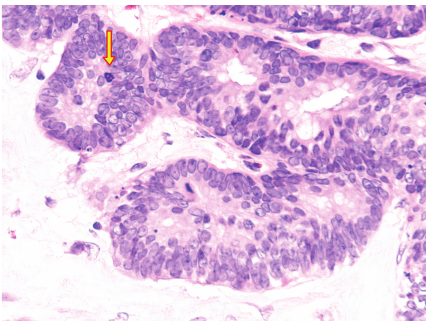
Figure 4: Photomicrograph showing low grade mucinous cys- tadenocarcinoma with complex cribriform glands invading the appendiceal wall (original magnification × 4, hematoxylin and eosin stain).